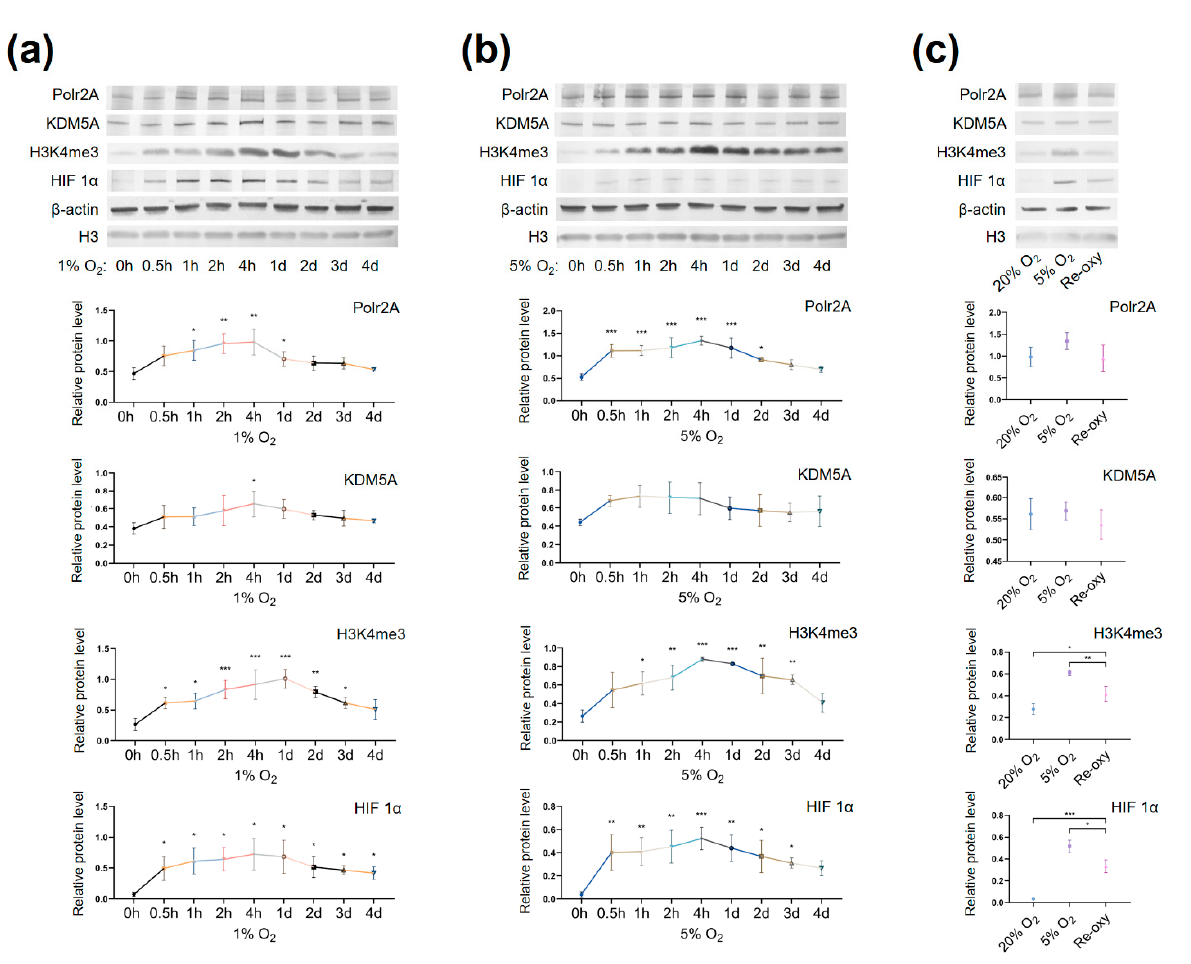
Figure 8. Protein levels of Polr2A, KDM5A, and H3K4me3 in varying oxygen conditions. After low-oxygen culture at 1% ( a ) and 5% O 2 ( b ), protein levels of Polr2A, H3K4me3, and HIF 1 α were higher than atmospheric oxygen culture. After intermittent hyperoxia exposure ( c ), protein levels of H3K4me3 and HIF 1 α were different from those after persistent atmospheric oxygen culture or persistent low-oxygen culture (5% O 2 ). In the boxplots, protein levels of Polr2A, KDM5A, and HIF 1 α expressed relative to β -actin levels, protein levels of H3K4me3 expressed relative to histone H3 levels. Three independent experiments were performed. Data were reported as mean ± SD. One-way analysis of variance with Dunnett’s post hoc test and independent samples t -test were used for statistical analysis. HIF 1 α was used as the indicator for hypoxia. HIF 1 α , hypoxia-inducible factor 1 α . * p < 0.05; ** p < 0.01; *** p < 0.001.